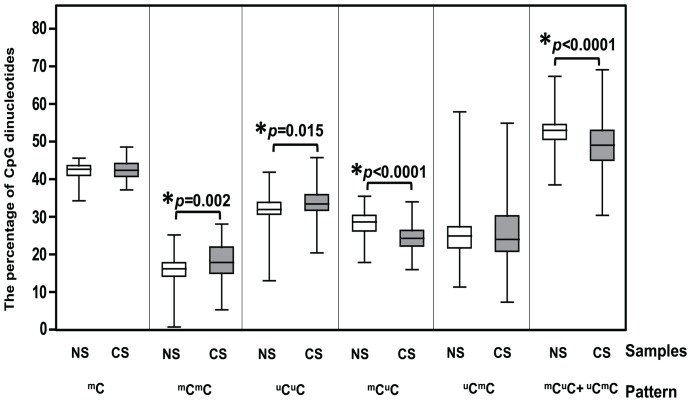
Percentage of each methylated CpG pattern in NS and CS.
mC represents the overall methylation level of the amplified LINE-1s. mCmC and uCuC represent hypermethylated and hypomethylated CpG of the amplified region, respectively. mCuC and uCmC represent two forms of partial methylation. mCuC+uCmC is the sum of partially methylated loci of both forms. The horizontal line within each box indicates the mean of the percentage. Stars indicate statistical significance at p<0.05. The results demonstrated that the CS had a significantly higher %mCmC and %uCuC and a lower %mCuC and %mCuC+%uCmC than the NS.